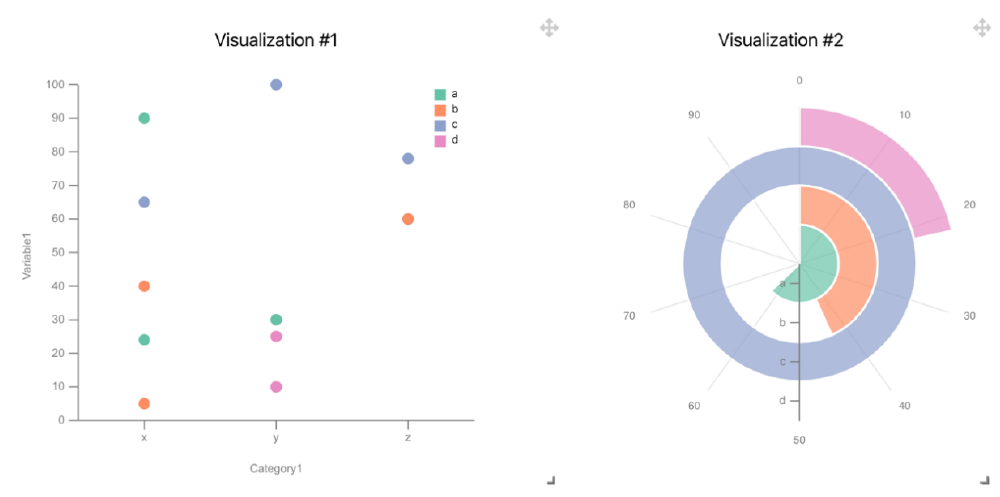
Figure 10. A sample dashboard modified by using the DSL. The second component shows the same information but using a polar coordinate system instead of a Cartesian coordinate system.